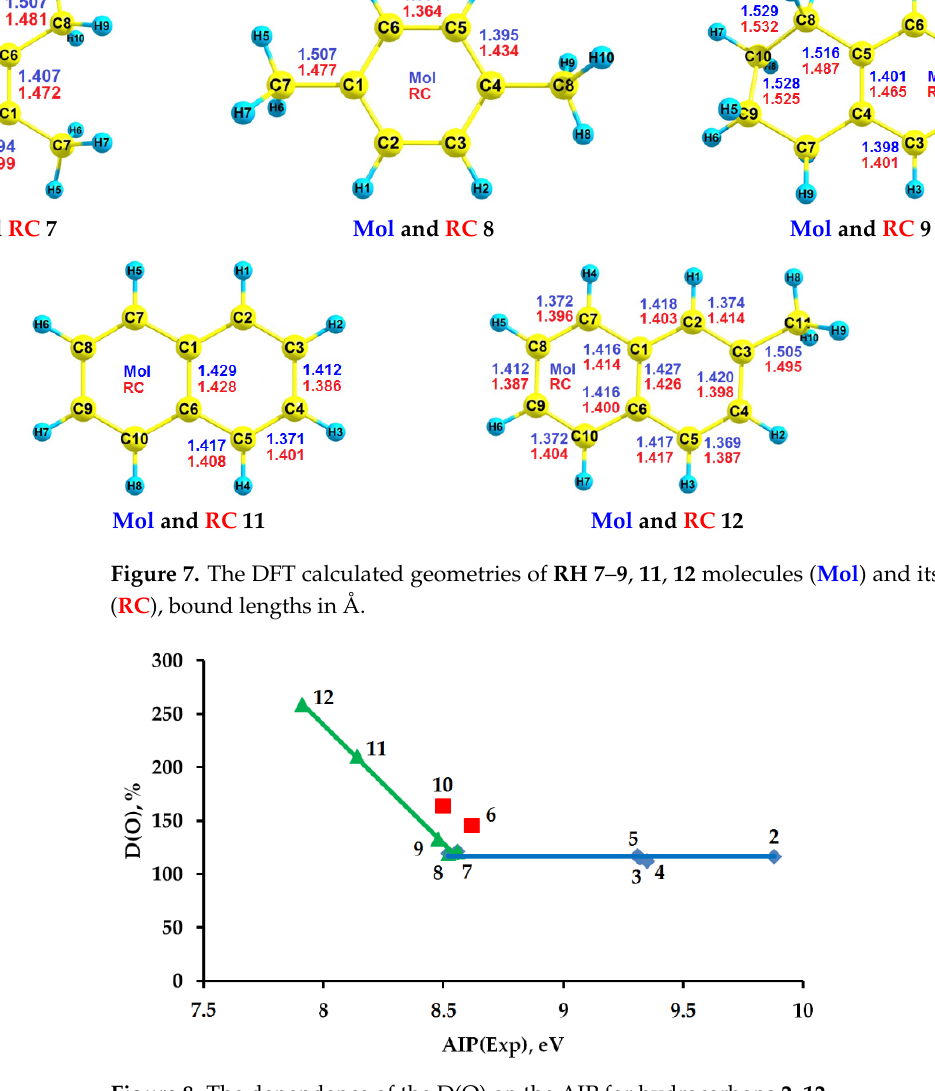
( RC ), bound lengths in Å.